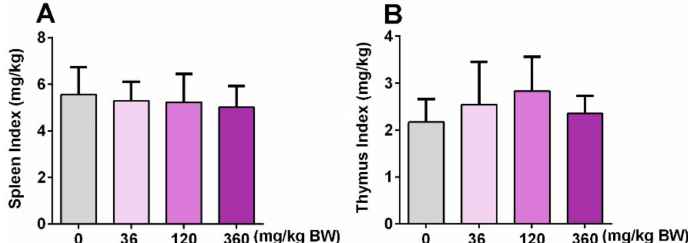
Figure 4. The e ff ect of GPP on immune organ index. The spleen index ( A ) and thymus index ( B ) were detected after treatment with 36, 120, 360 mg / kg BW for 30 days in four groups (N = 12). The spleen or thymus index was calculated by the spleen or thymus weight (mg) / bodyweight (kg). Data were expressed as mean ± SEM (N =